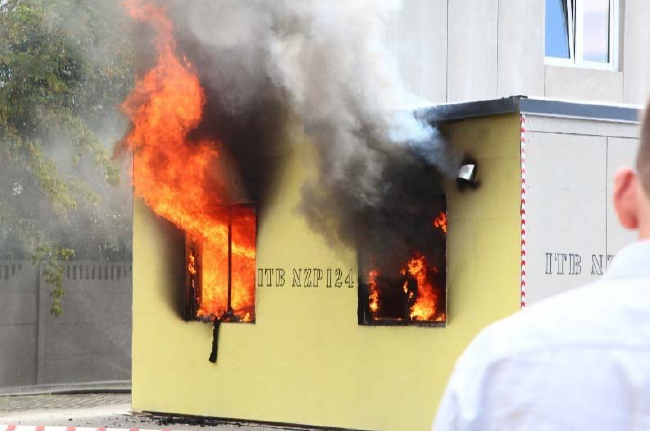
Figure 1. View of flames escaping from a room involved in a fully developed standard fire, during a field test. (Author: E. Kotwica).